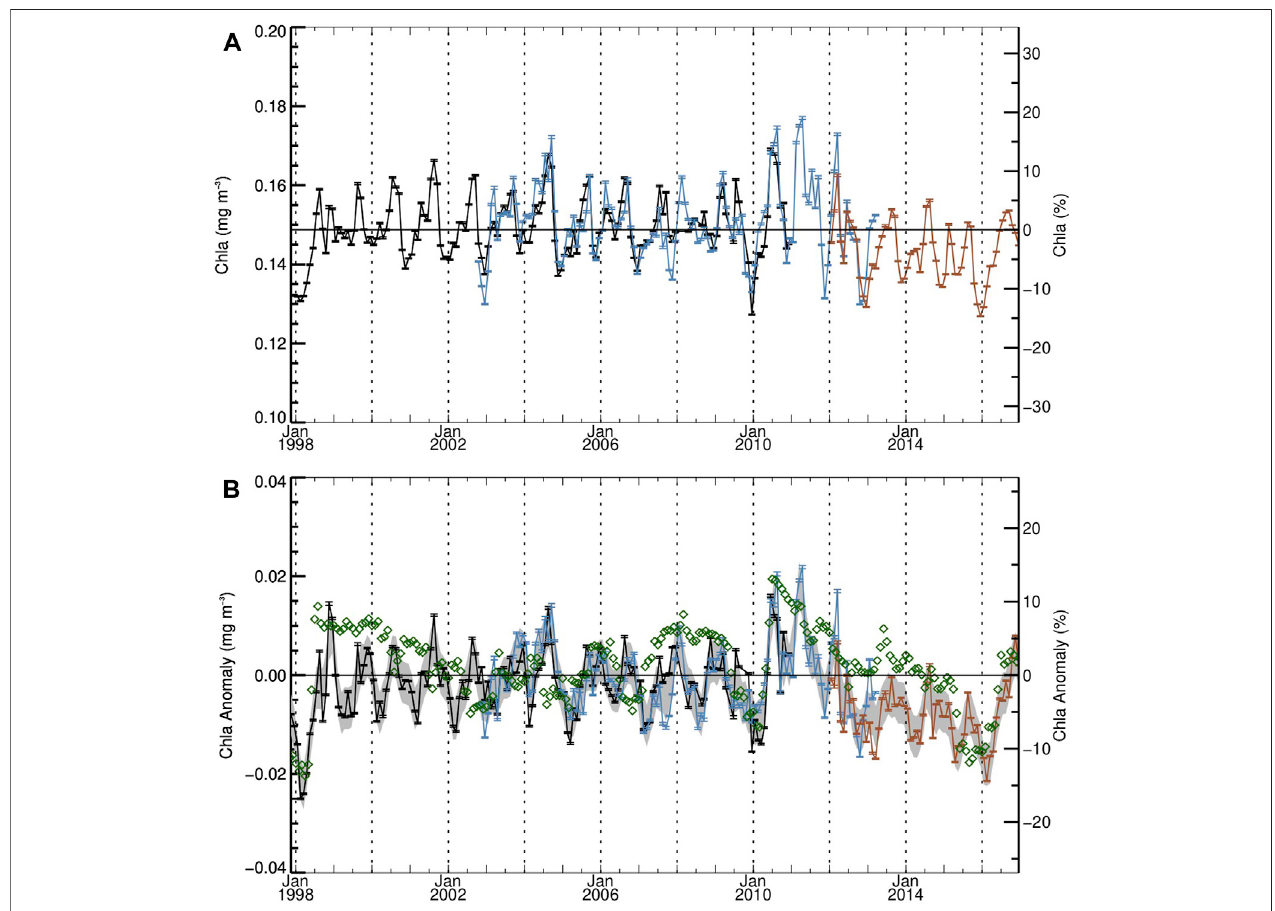
FIGURE3| Nineteen-yearmulti-missiontimeseriesofmonthlymeanchla,averagedovertheglobaldeepoceans(greaterthan1000-mdepth)betweenlatitudesof ± 40 ° , spanning years 1998 through 2016. Datafrom SeaWiFS isin black, Aqua/MODISin blue, SNPP/VIIRS in brown. Panel A shows the absolute value of chlatrends, while Panel B shows the de-seasonalized anomaly of chla after subtraction of the mean seasonal cycle. The green diamonds in Panel B show the Multivariate ENSO Index (MEI, Wolter and Timlin, 1998), inverted and scaled to match the dynamic range of the chla anamolies.